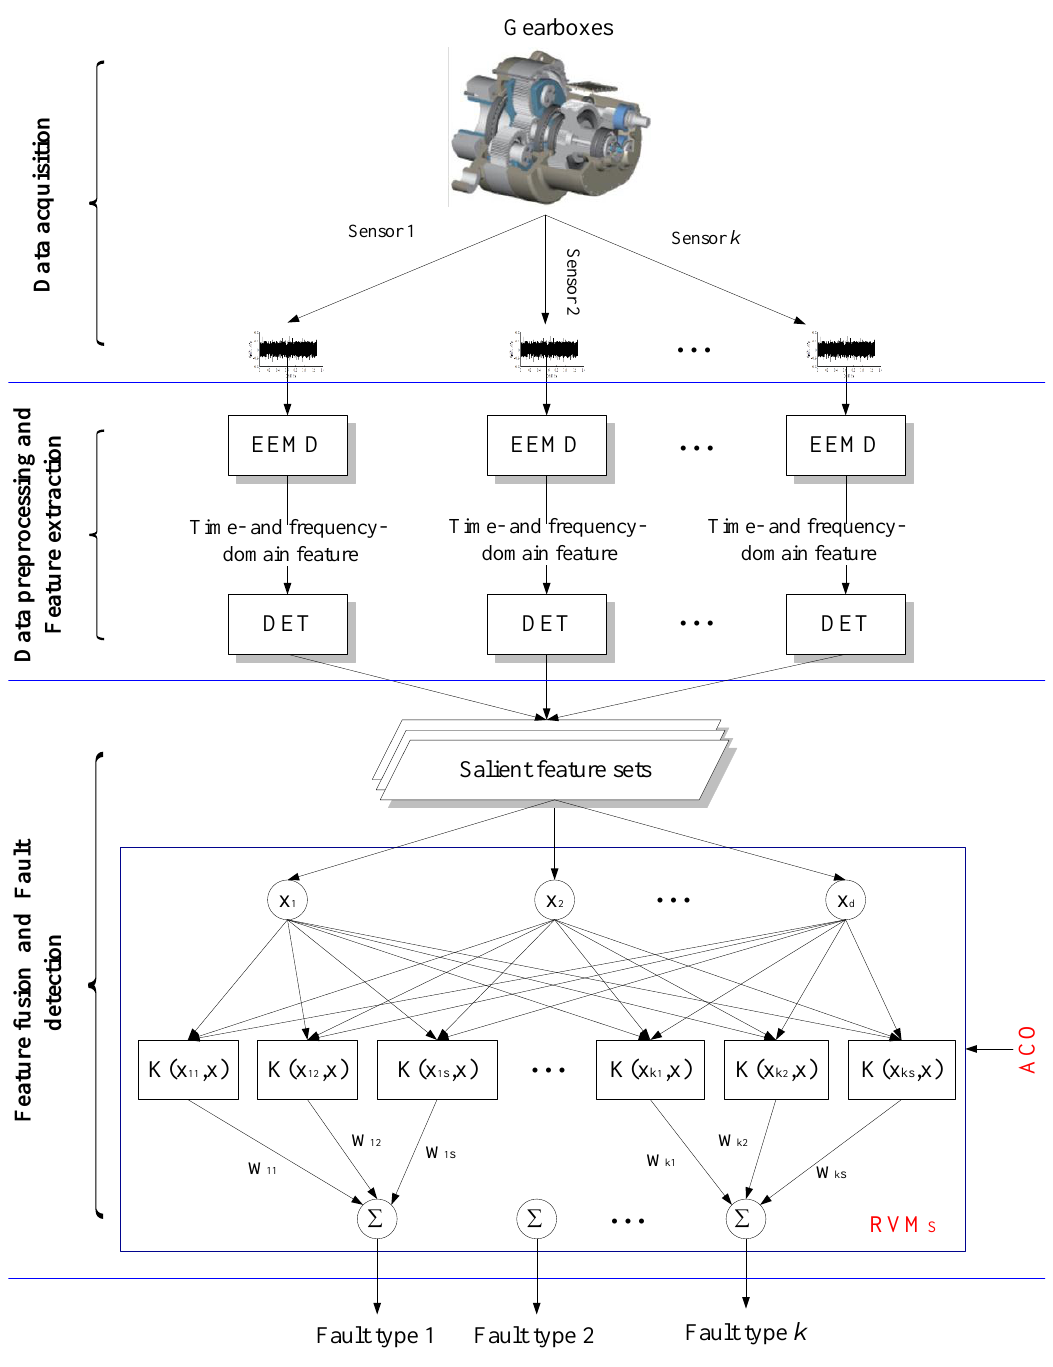
Figure 4. Multi-sensor data fusion strategy of the gearbox fault